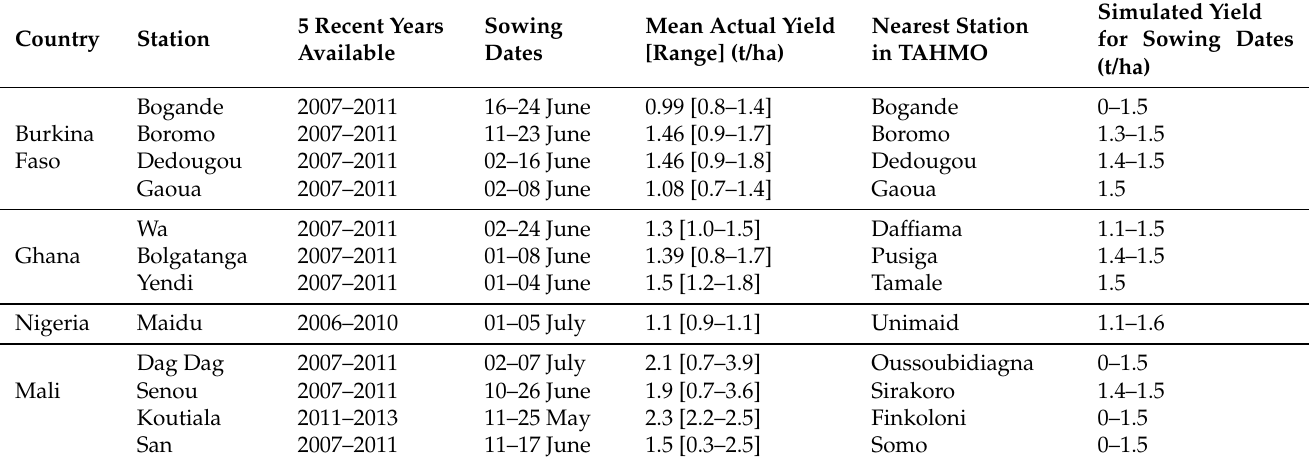
Table 4. Comparison of actual yield ranges (from Global Yield Gap Atlas